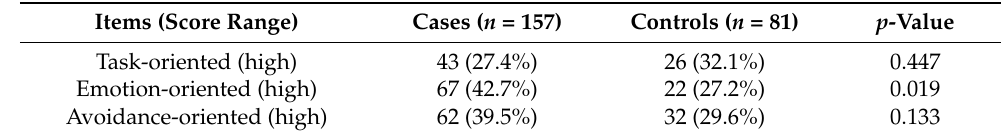
Table 3. Comparison of CISS survey results between women with thrombophilia and recurrent pregnancy loss (cases), women with thrombophilia and recurrent pregnancy loss who achieved a normal pregnancy, and preterm or full-term birth